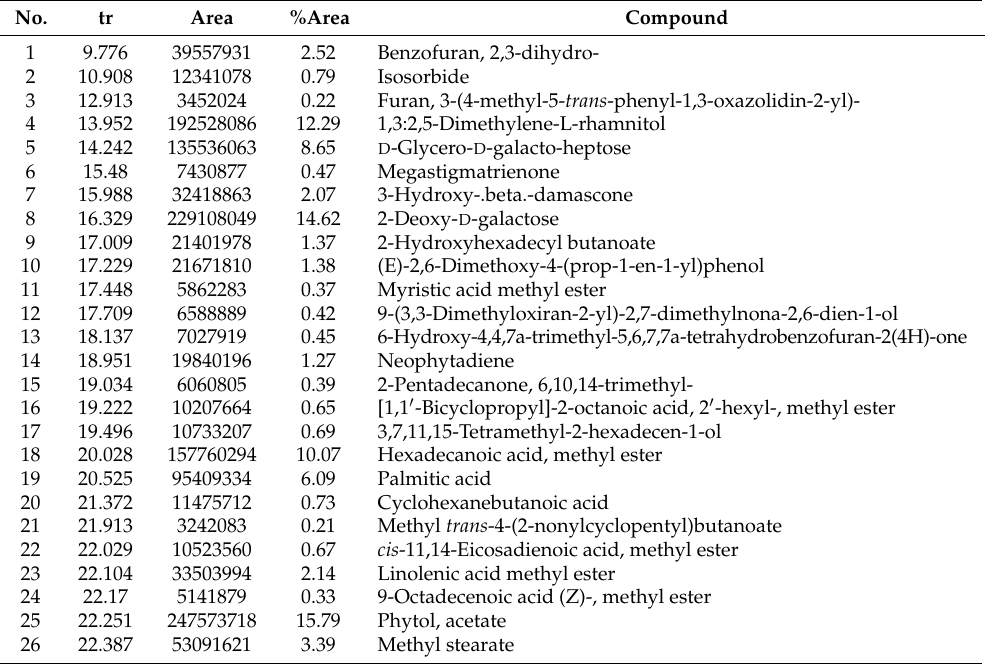
Table 4. Composition of the extracts of leaves of C. hissaricus (% of total fraction; mass%, GC).